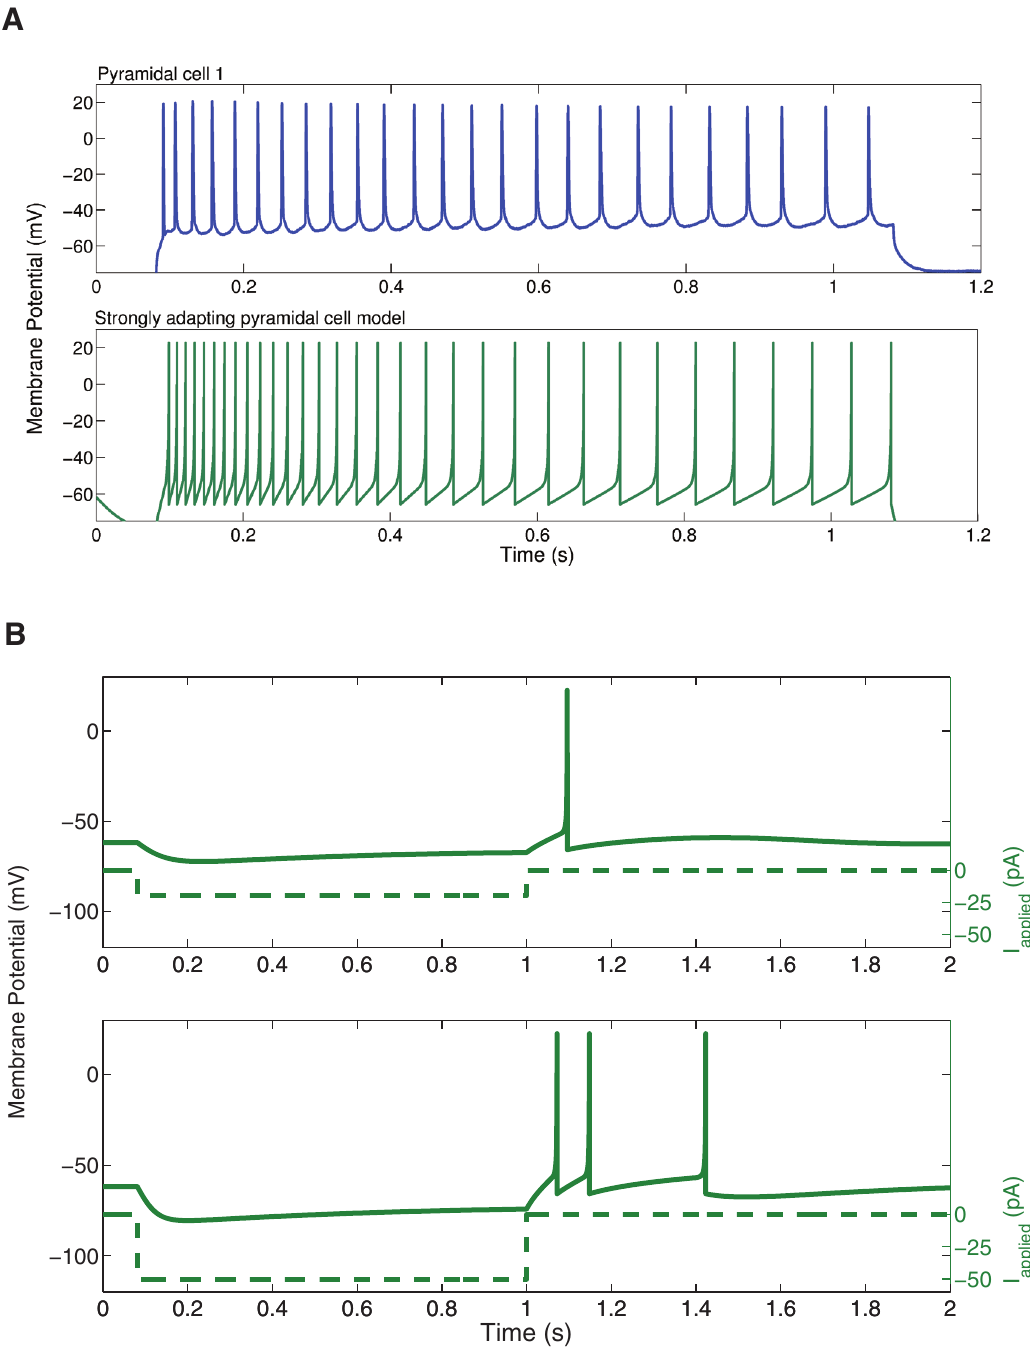
Figure 4. A : An example intracellular recording of Pyramidal cell 1 during current clamp with applied current of 188 pA (top, blue) is compared with the firing of our strongly adapting pyramidal cell model, also with an applied current of 188 pA (bottom, dark green). The firing rates and amount of adaptation of the model are similar to those of the experiment. B : Two examples of rebound firing in our strongly adapting model. In each case, a one-second step of hyperpolarizing input is applied (shown as dashed lines; top: 20 pA step, bottom: 50 pA step). In each case, the strongly adapting model produces rebound spiking (solid line), where more spiking occurs for larger amounts of hyperpolarizing